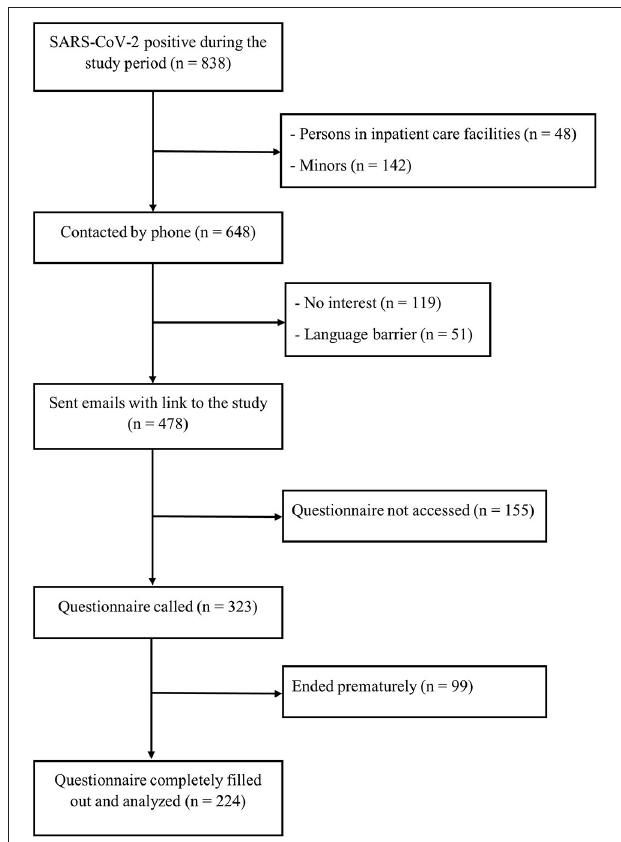
FIGURE 1 | Flow chart of study